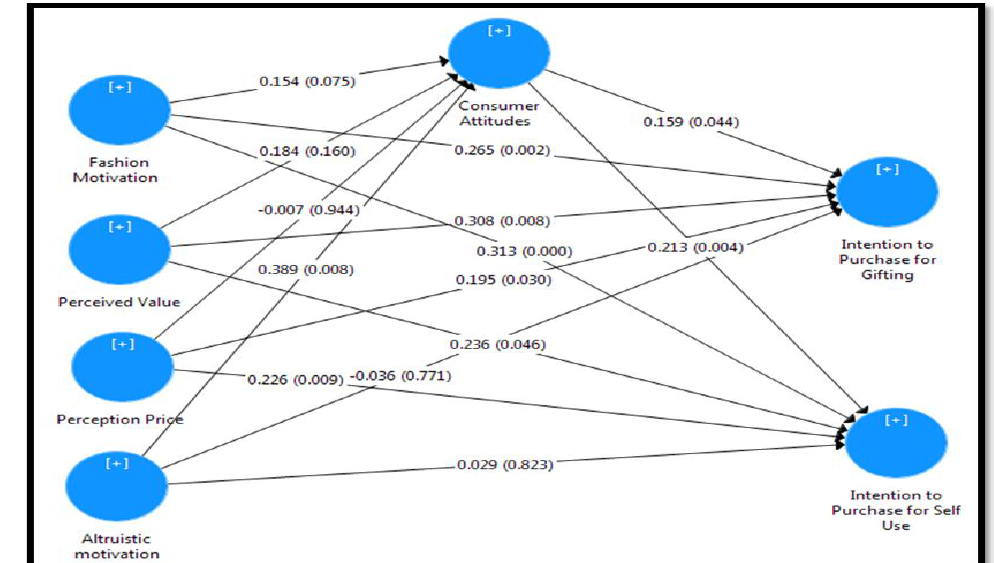
Figure 2. Structural model. Table 3. Results of structural model evaluation and hypotheses testing.